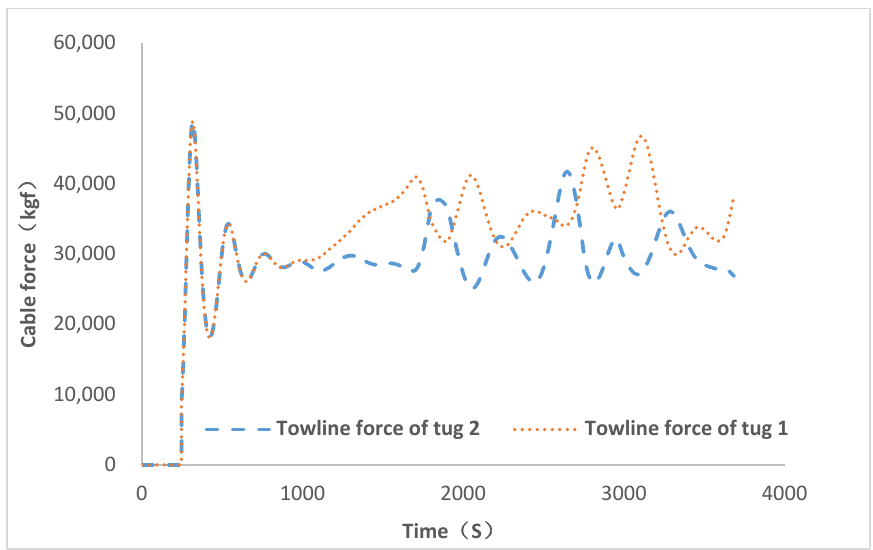
Figure 15. Analysis diagram of slewing cable force of towing system under wind force.